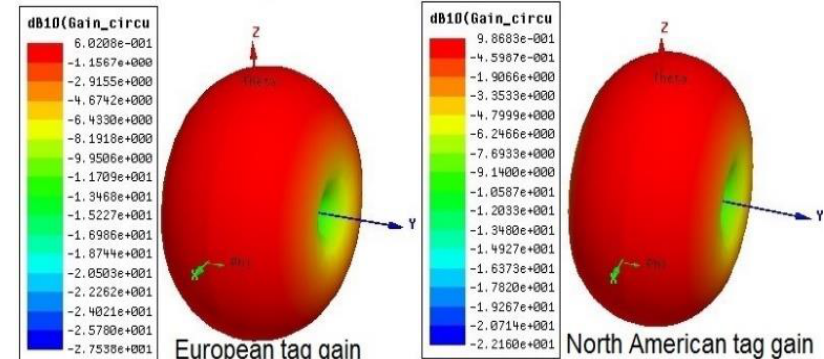
Figure 7. Torus-shaped omnidirectional radiating pattern of antenna gain: for European tag, 0.6 dB (2.75 dBi); for North American tag, 0.98 dB (3.14 dBi).